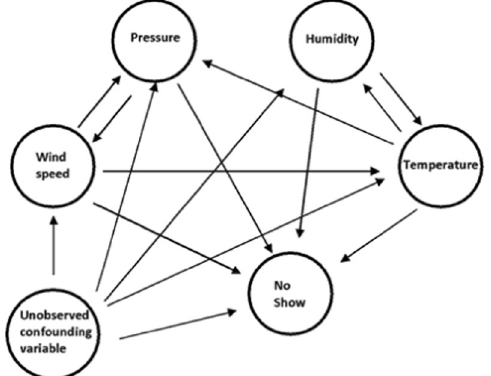
Fig. 7 Illustration of the estimated causal relation among weather-related features and no-show at medical appointments along with the graphical model. Further experiments and analysis will be needed to obtain the real causal